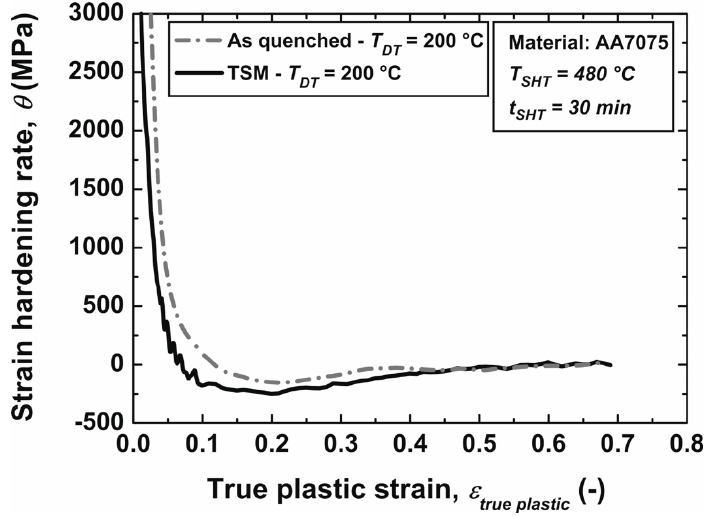
Figure 4. Strain ‐ hardening rate of as ‐ quenched and TSM conditions in function of true plastic strain 𝜀 (cid:3043)(cid:3039)(cid:3028)(cid:3046)(cid:3047)(cid:3036)(cid:3030) (cid:3047)(cid:3045)(cid:3048)(cid:3032) at the deformation temperature of 𝑇 (cid:3005)(cid:3021) (cid:3404) 200 °C and strain rate of 𝜀(cid:4662) (cid:3404) 0.1 s (cid:2879)(cid:2869)